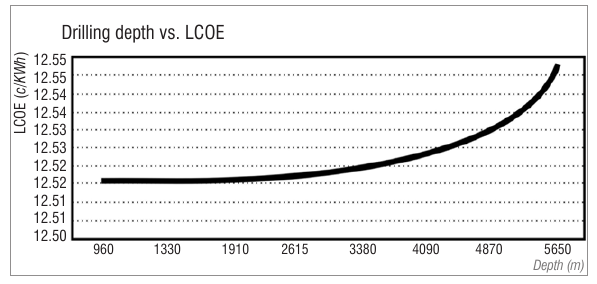
Figure 9: Graph illustrating the effect of an increasing drilling depth on the levelised cost of electricity (LCOE) for a hypothetical enhanced geothermal system.